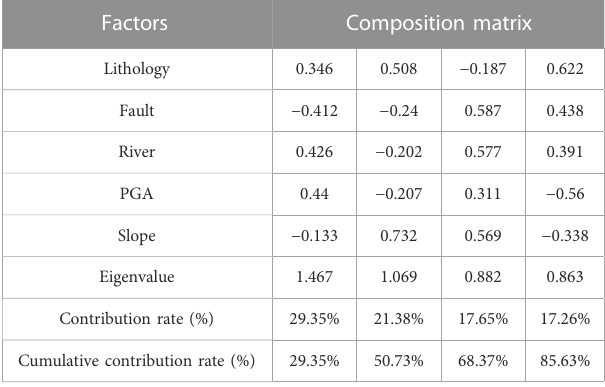
TABLE 4 Composition matrix table of landslide factors in the study area.